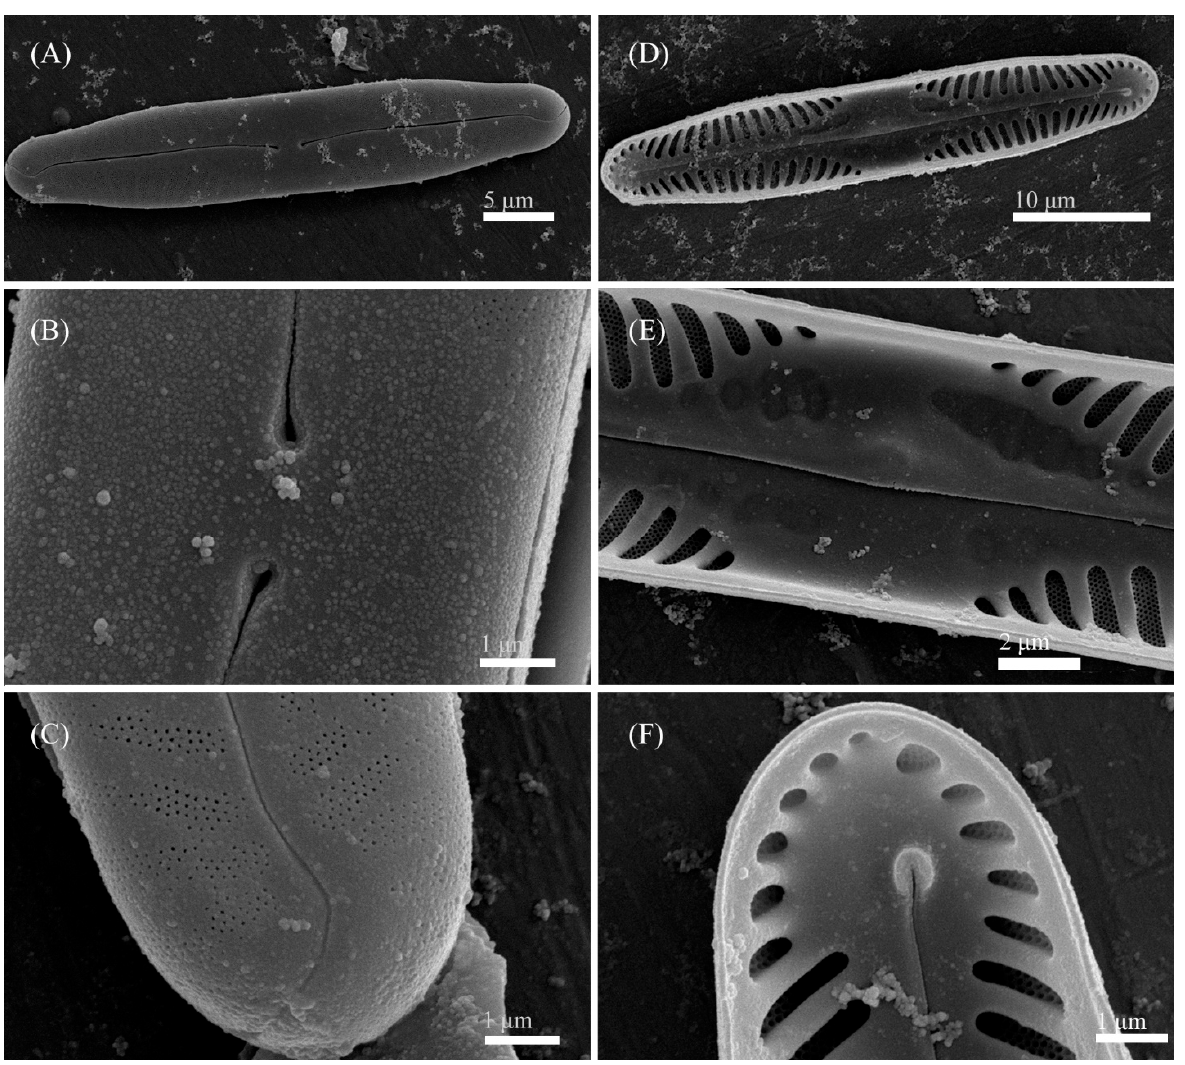
Figure 4. Pinnularia minigibba Kezlya, Maltsev, Krivova et Kulikovskiy sp. nov. Strain VP284, sample No. 07042. Scanning electron microscopy. ( A – C ) External views. ( D – F ) Internal views. ( A , D ) The whole valve. ( B , E ) Central are. ( C , F ) Valves ends. Arrows indicate the ghost striae.